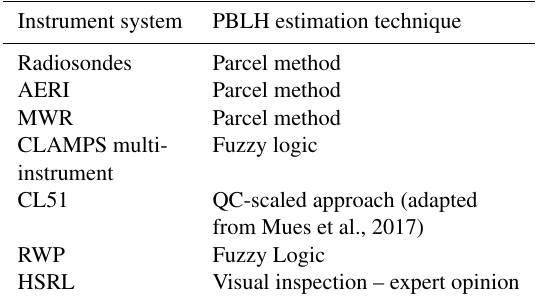
Table 2. Instrument and methods used to discern